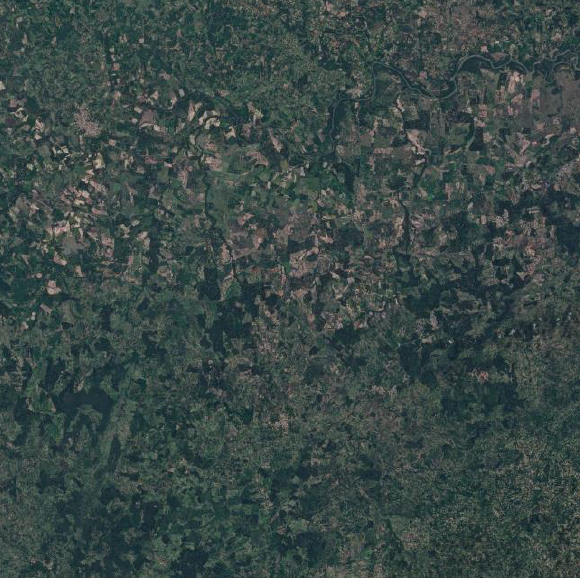
Figure 12: Tile of interest and area of overlap of neighboring tiles which are clipped to be blended with tiles of interest.